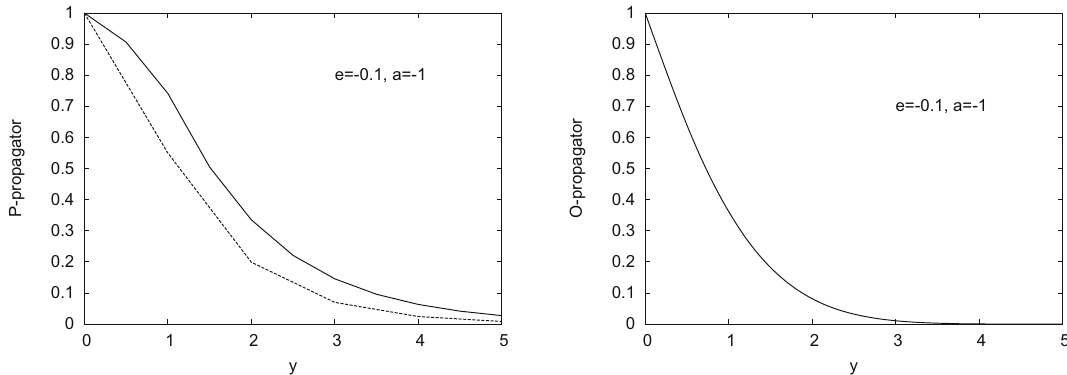
Fig. 10 The solid curves show pomeron (left panel) and odderon (right panel) propagators as functions of rapidity μ = 0 . 1, λ = 1. The dashed curve in the left panel shows the pomeron propagator in absence of the odderon (only pomeron